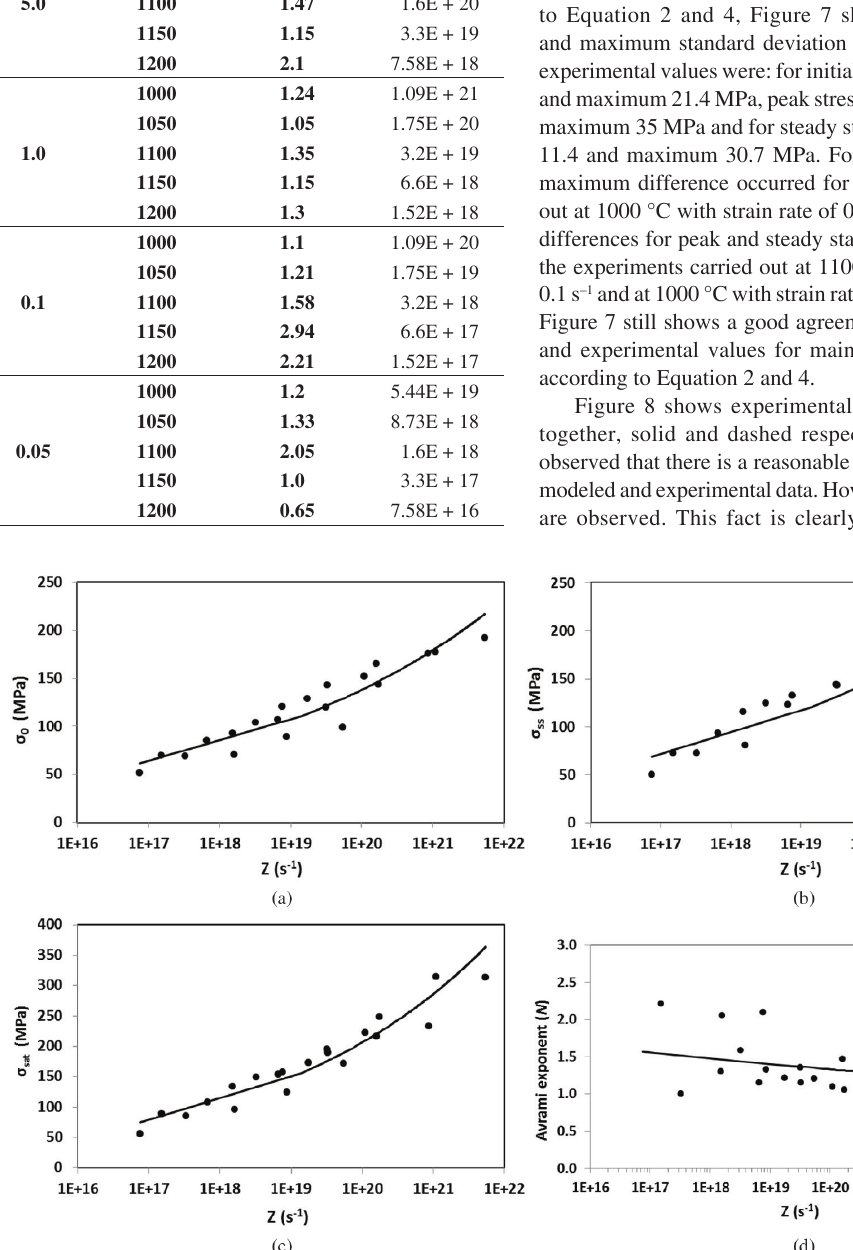
), (b) steady state stress ( σ ), (c) saturation stress and (d) Avrami exponent ( N ) with Zener o ss